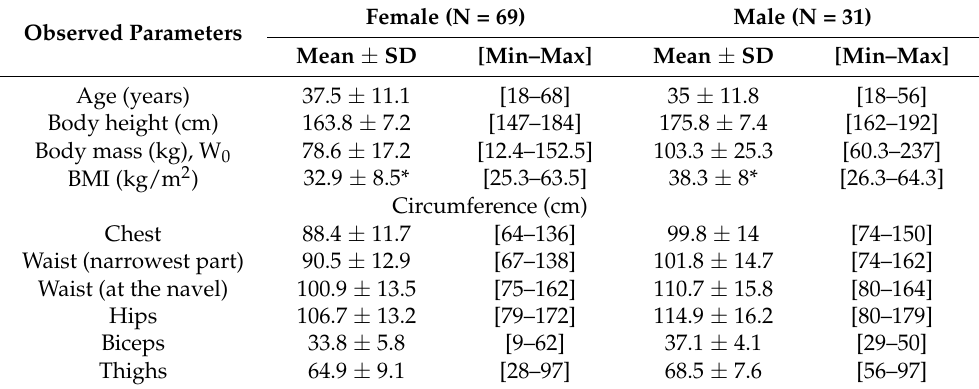
Table 1. Basic anthropometric parameters of the subjects on the first medical examination. Observed